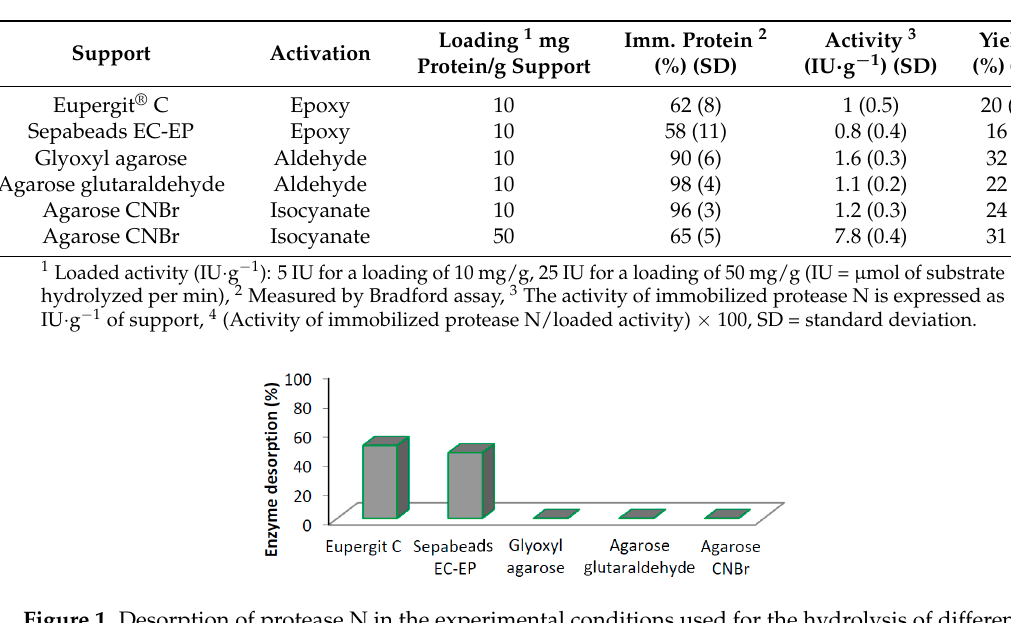
Table 2. Covalent immobilization of protease N.